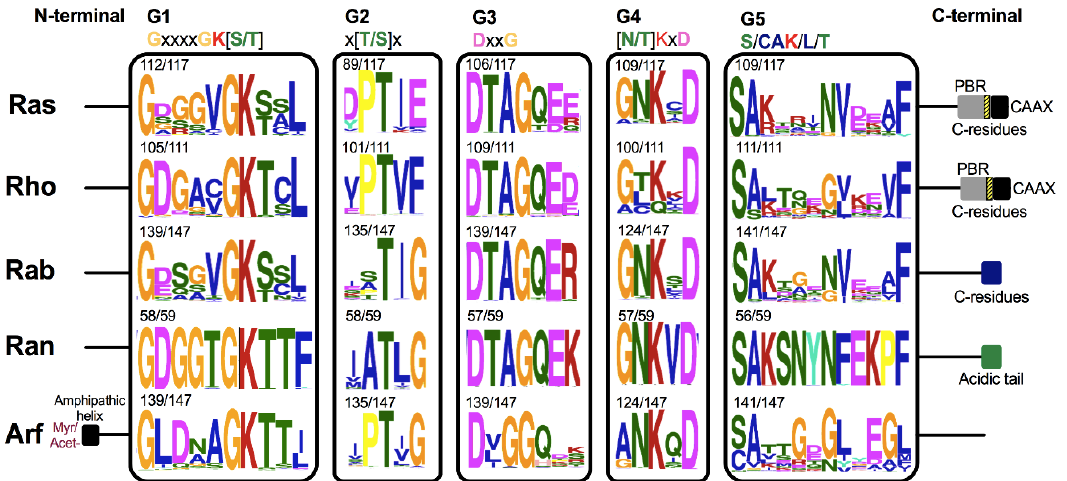
Figure 4. Schematic representation of the Ras, Rho, Rab, Ran, and Arf families’ motifs and their biochemical features for their post-translational modifications. The G1 to G5 motifs for each family are within the rectangles and each of the consensus sequences are indicated above. The total of motifs found among the proteins analyzed for each family is shown on top of each motif (number of motifs found/total proteins analyzed). The analysis was carried out on MEME-suite [35]. The amphipathic helix for Arf proteins is indicated at N-terminal as well as their possible myristoylation or acetylation sites. At the C-terminal, the PBR (gray rectangles), the C-residues for palmitoylation in the HVR (black and yellow rectangles with stripes), and the CAAX motif (black rectangles) for Ras and Rho families are indicated, as well as the C-residues motifs (blue rectangles) of Rab and the acidic tail (green rectangle) of Ran proteins are indicated.